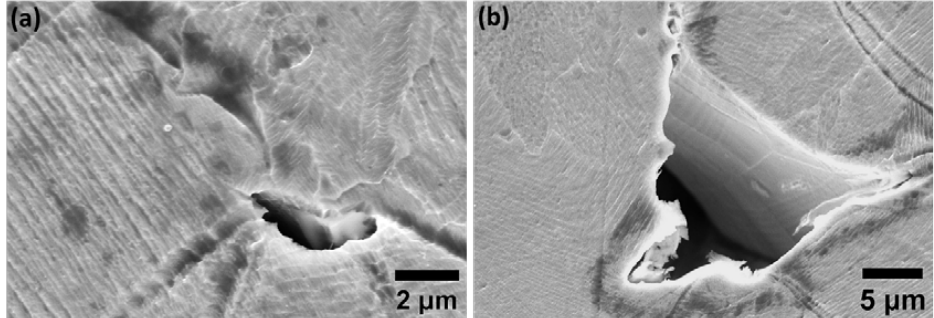
Figure 2. (a) and (b) SEM microstructural analysis of the LOF pores present in the specimens of group three.